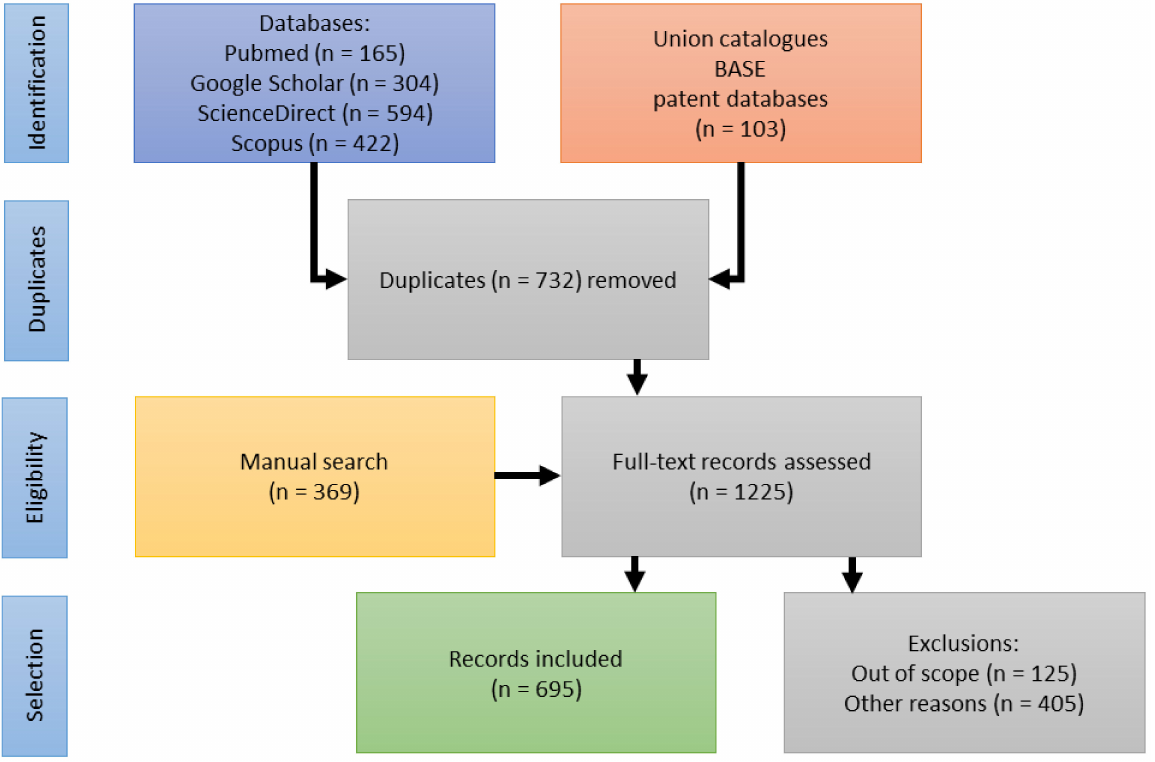
Figure 2. Flow diagram of the reference identification, screening and